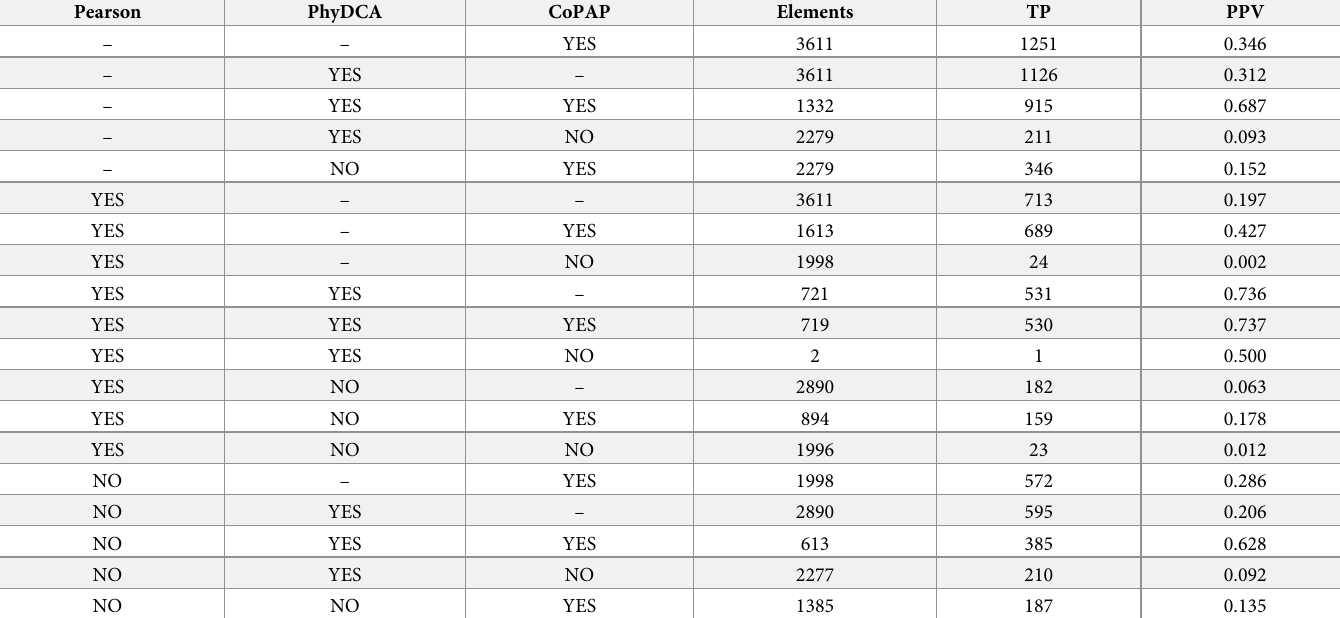
Table 1. Comparison of the predictions of Pearson correlation, PhyDCA and CoPAP. –We analyze the different combinations between the 3611 highest scoring pre- dictions according to each of the three scores. In the first three columns, “YES” means that predictions are retained for the concerned score, “NO” means that predictions are discarded by the score, and “–” indicates, that the score is not taken into